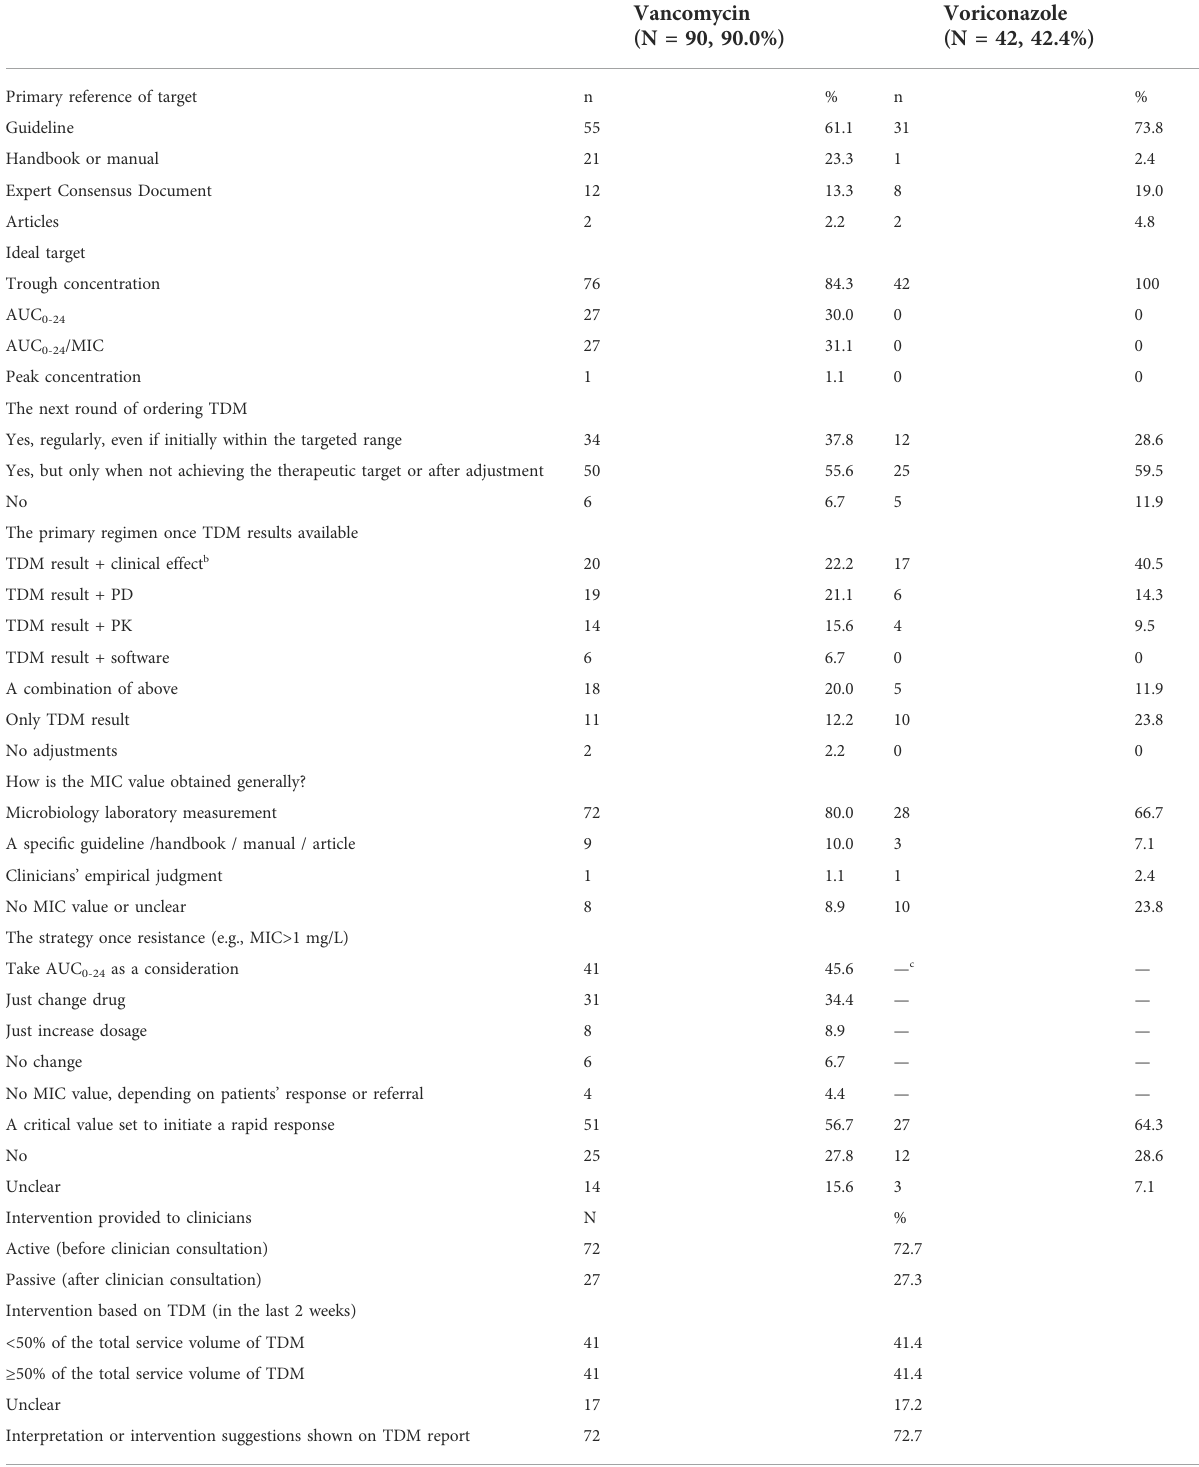
TABLE 5 Clinical vignettes for interpretation